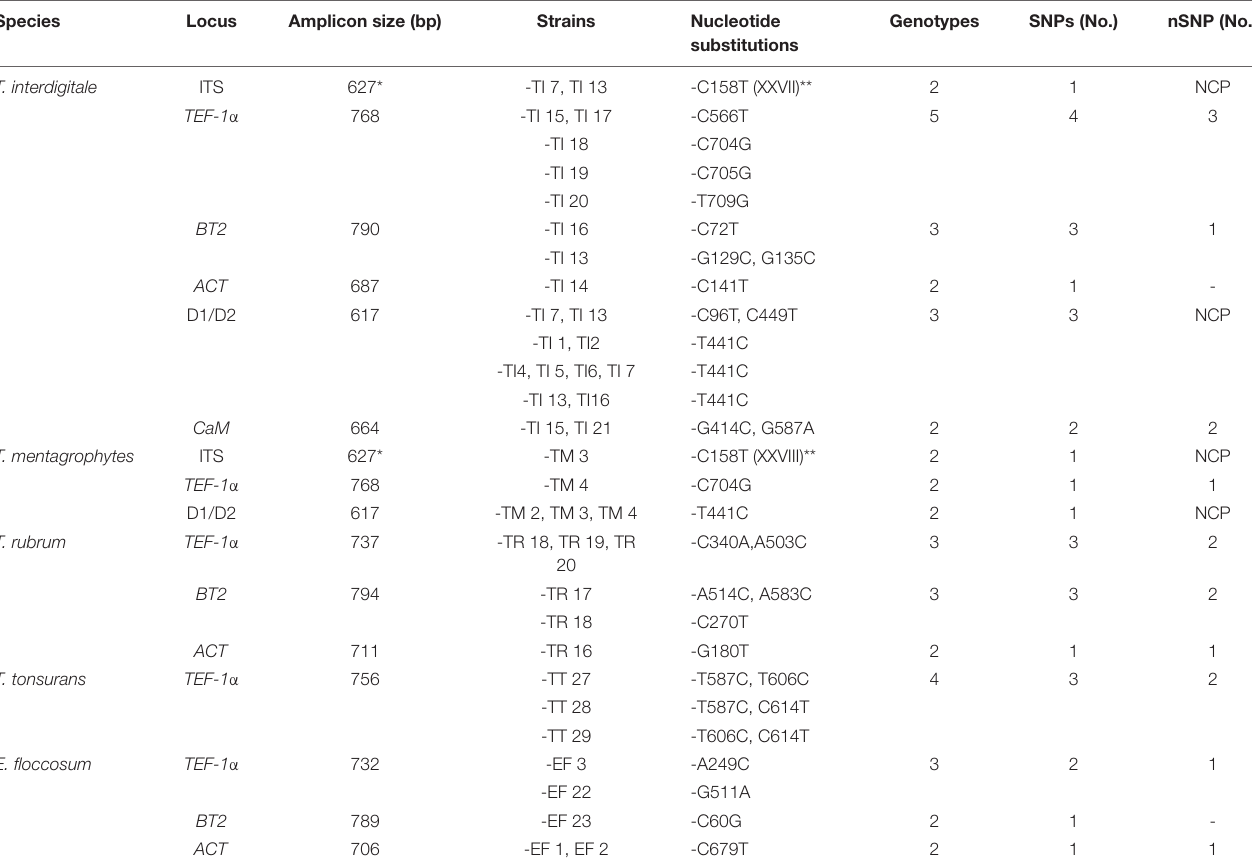
TABLE 2 | Characteristics and the nucleotide substitutions of the housekeeping loci studied. Species